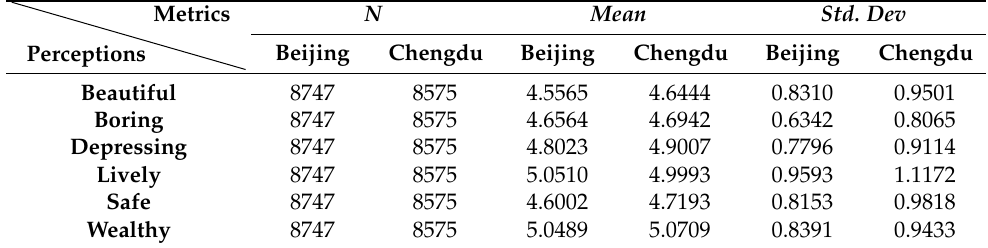
Table 8. Performance of the perception models (RMSE).